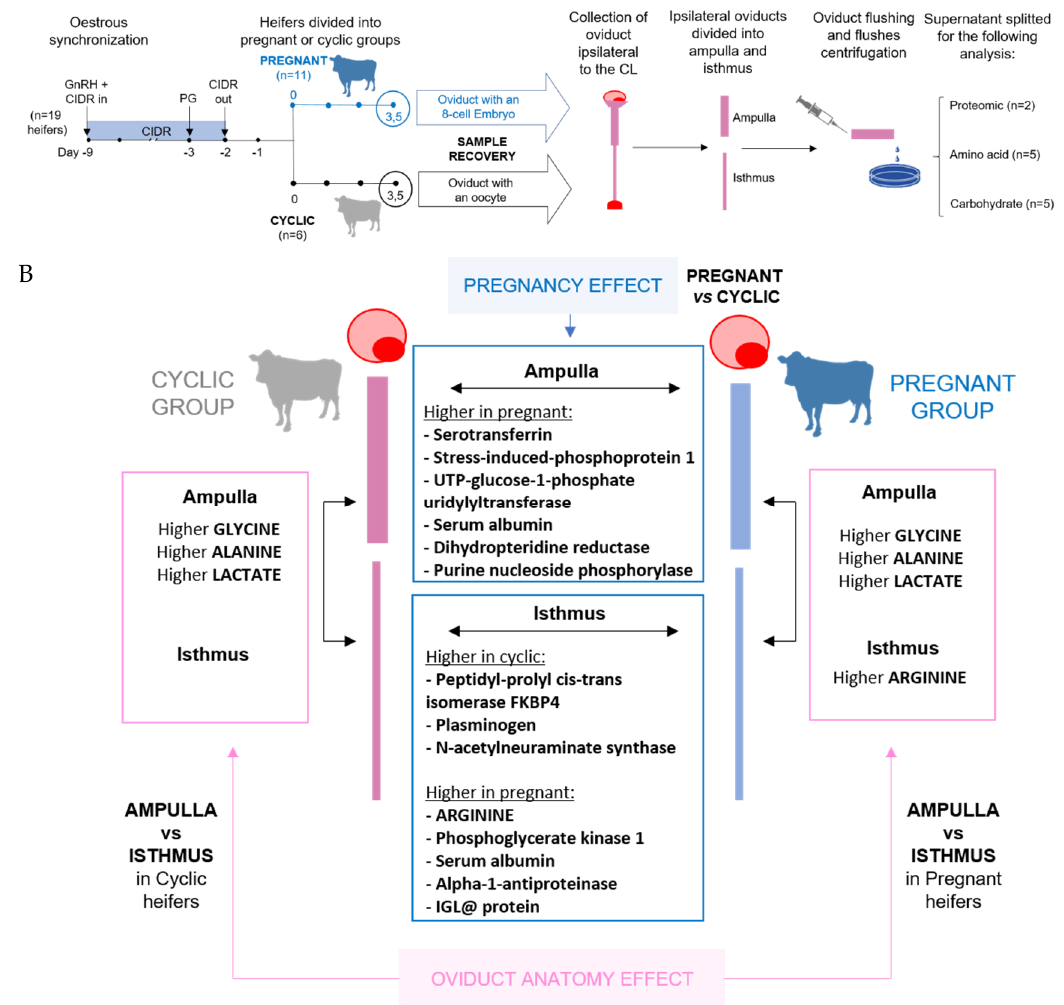
Figure 1. Schematic representation of the experimental design ( A ) and differences found in the oviductal fluid content in terms of proteins, amino acids and carbohydrates due to location within the oviduct or the presence of an embryo ( B ). Abbreviations: Gonadotropin-Releasing Hormone (GnRH), Controlled Internal Drug Release (CIDR), prostaglandin (PG), corpus luteum (CL).